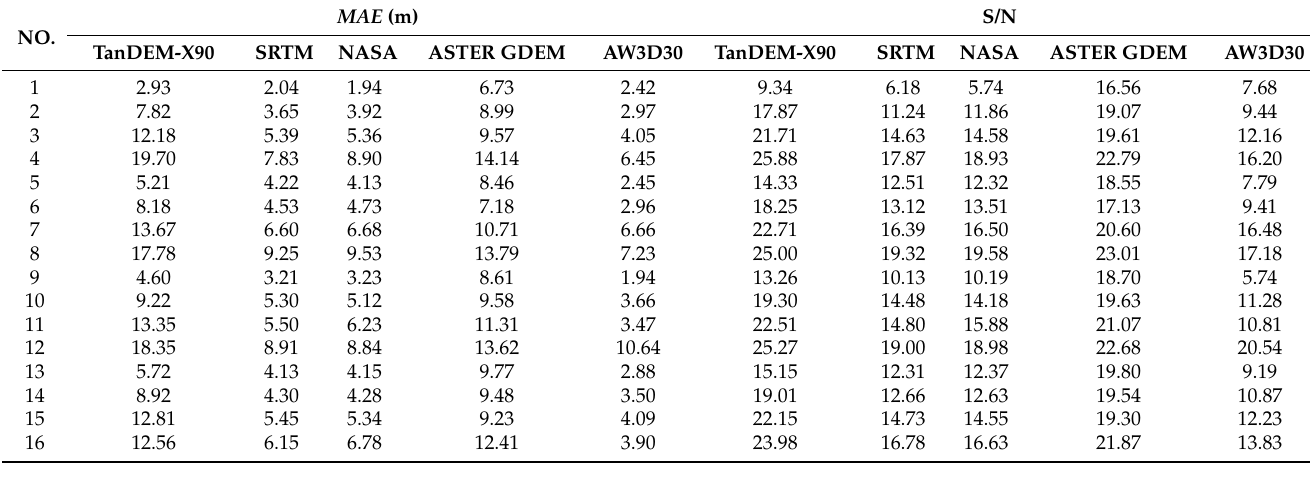
Table 5. The results of Taguchi experiment, in which the S/N ratio of each experiment is generated by different combinations of factors and levels.